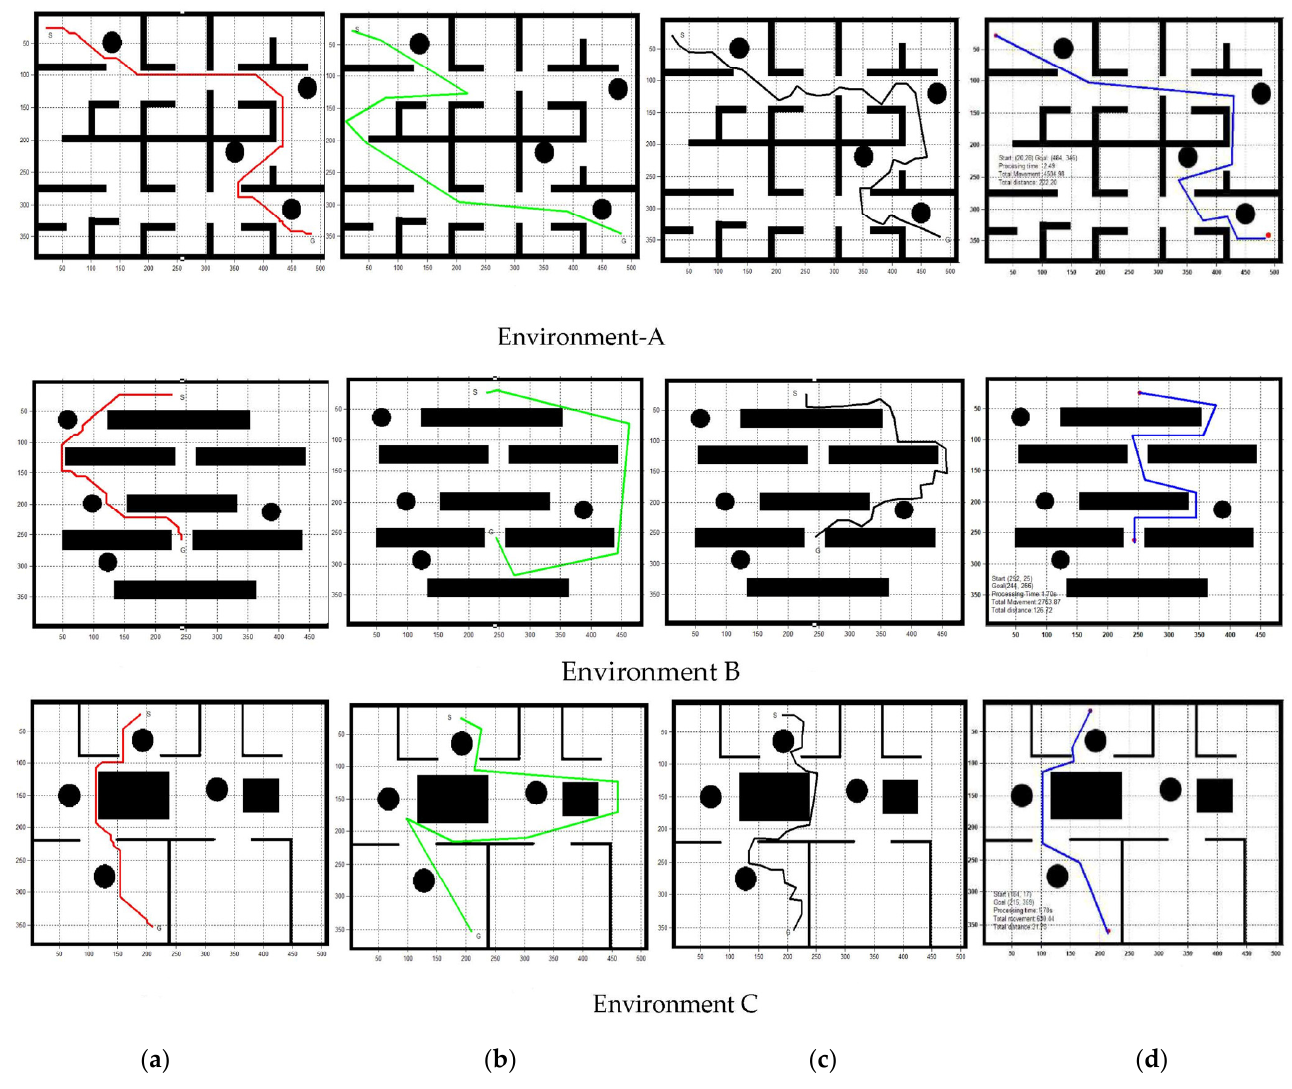
Figure 11. Comparison between ( a ) A*, ( b ) PRM, ( c ) RRT, and ( d )